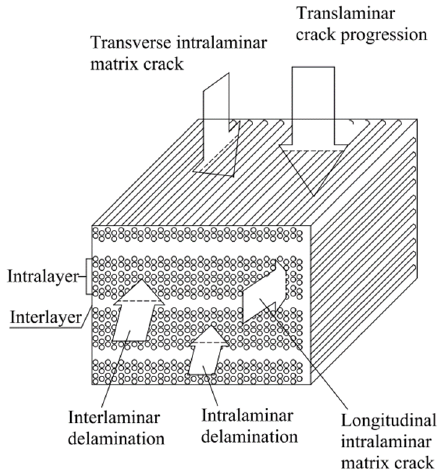
Figure 17. Delamination and cracks directions [143].